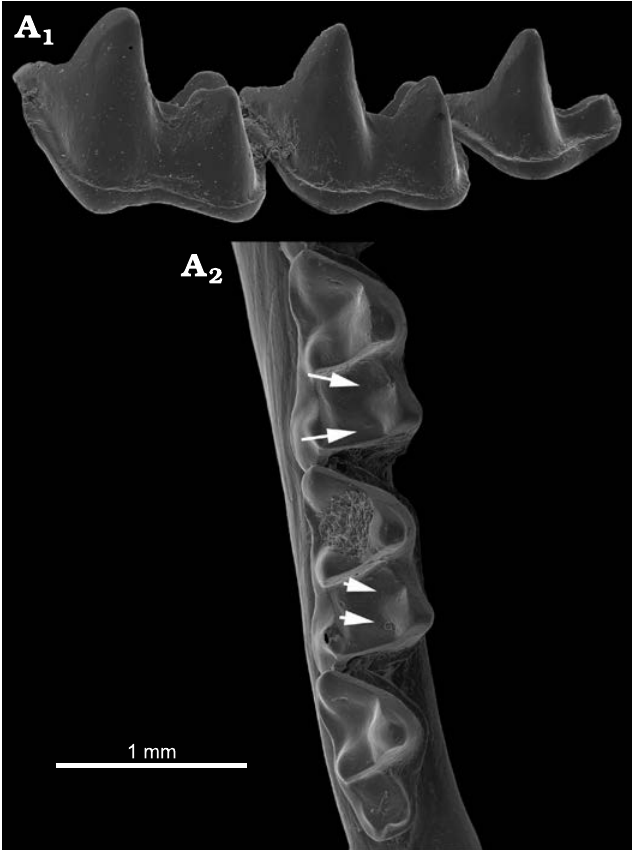
Fig. 12. Vespertilionid bat Murina suilla (Temminck, 1840) (AMNH 217012) from Malaysia, Recent. Left lower molars in anterolabial view (A 1 ) showing deeply excavated cristids obliqua in m1–m2 but no within-crest notches; and in occlusal view (A 2 ) showing accessory troughs (arrows) in